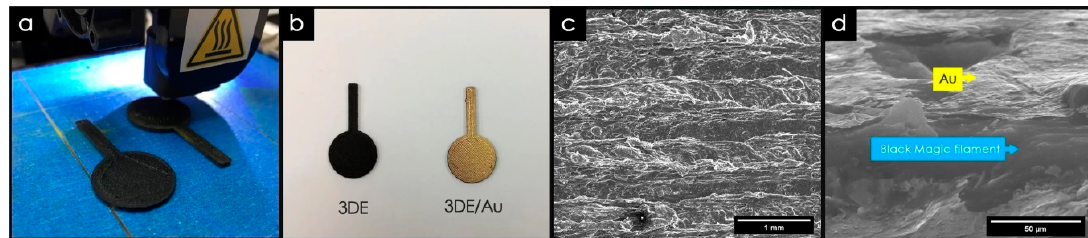
Figure 13. Physiochemical characterization. ( a ) Optical image of the 3D printing process, ( b ) 3D printed electrode used throughout the study. ( c ) FESEM image of 3DE/Au electrode, and ( d ) corresponding magnified cross-sectional area. Reproduced from [202], with permission from Springer Nature, 2018.